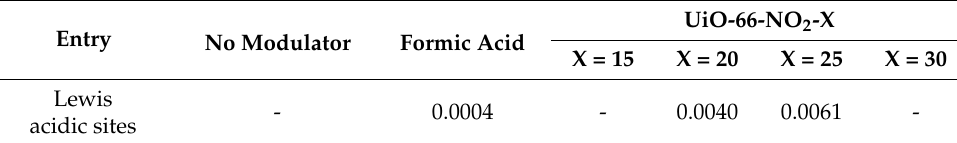
Figure 2. PXRD patterns of UiO-66-NO 2 -X in the low-angle (3–9°) region. Table 1. Lewis acidic sites (mmol base per mg) in UiO-66-NO 2 -X. Table 1. Lewis acidic sites (mmol base per mg) in UiO-66-NO 2 -X. - Not detected.